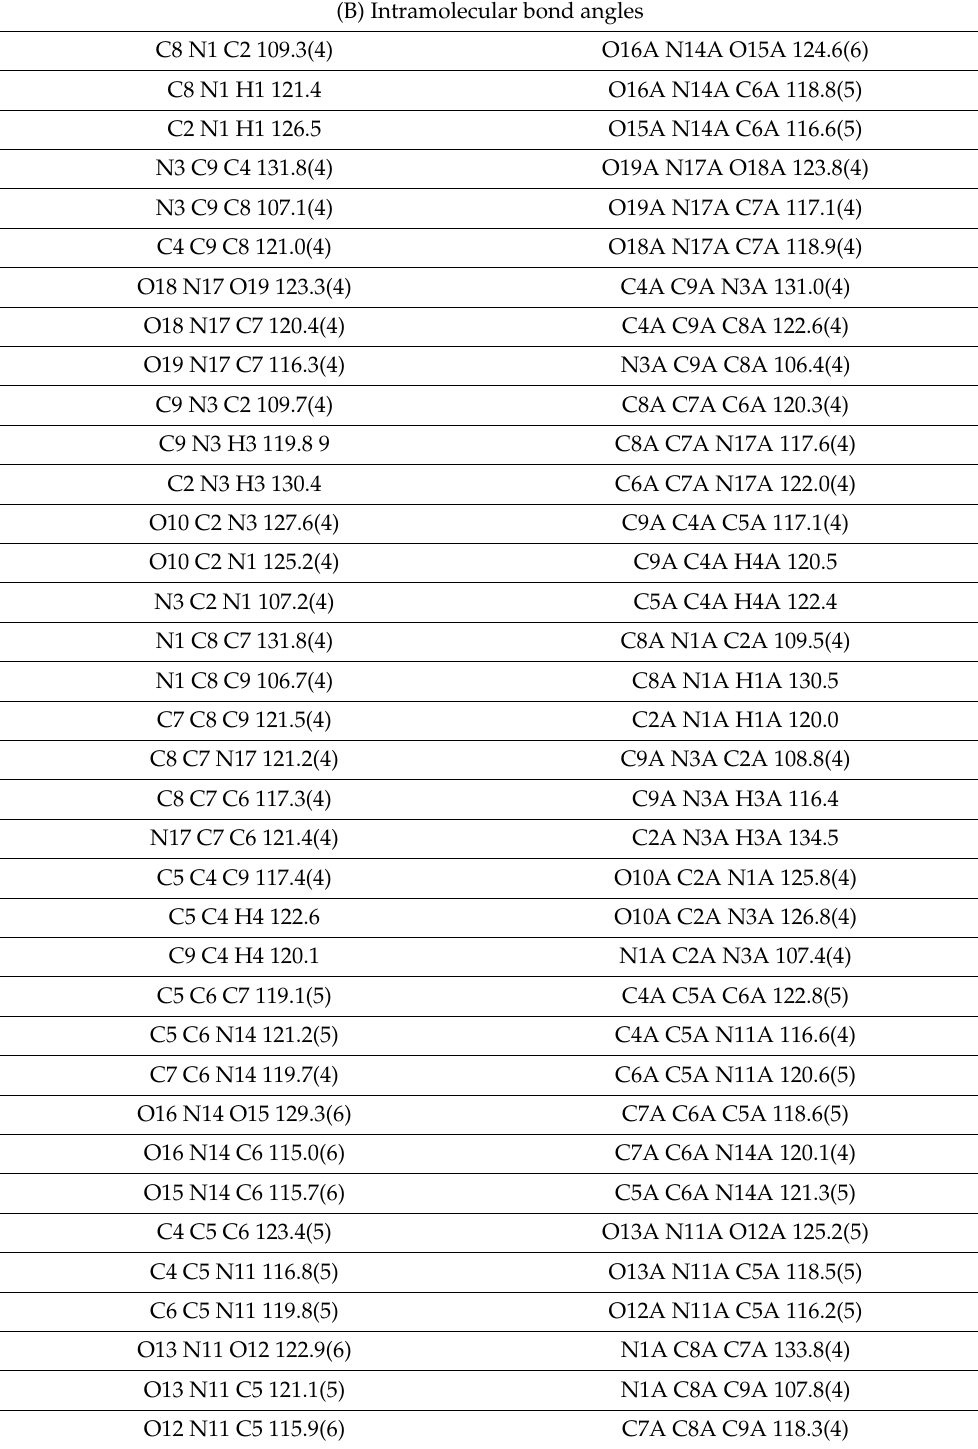
(B) Intramolecular bond